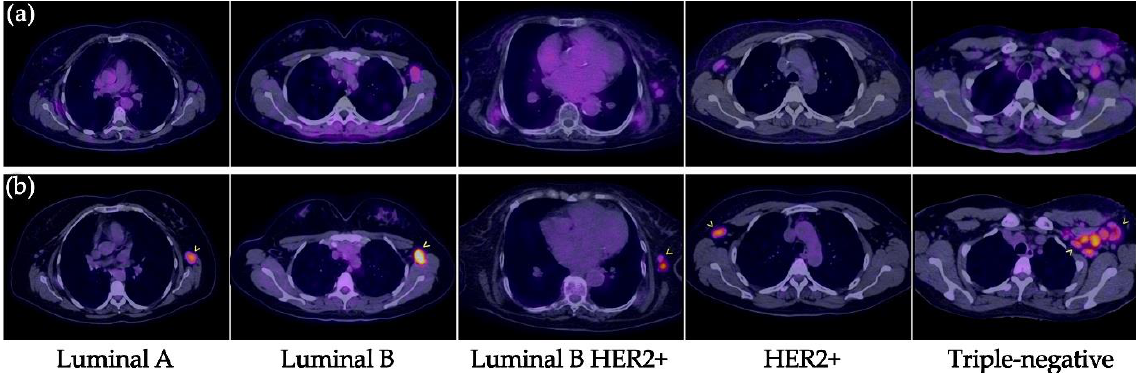
Figure 4. Lymph node metastases in breast cancer. ( a ) [ 99m Tc]Tc-iFAP SPECT/T and ( b ) [ 18 F]FDG PET/CT. All malignant-appearing axillary lymphadenopathies are hypermetabolic; however, most of them (arrowheads) exhibit reduced or absent [ 99m Tc]Tc-iFAP uptake in all molecular subtypes of breast cancer (lesion sizes >8 mm).